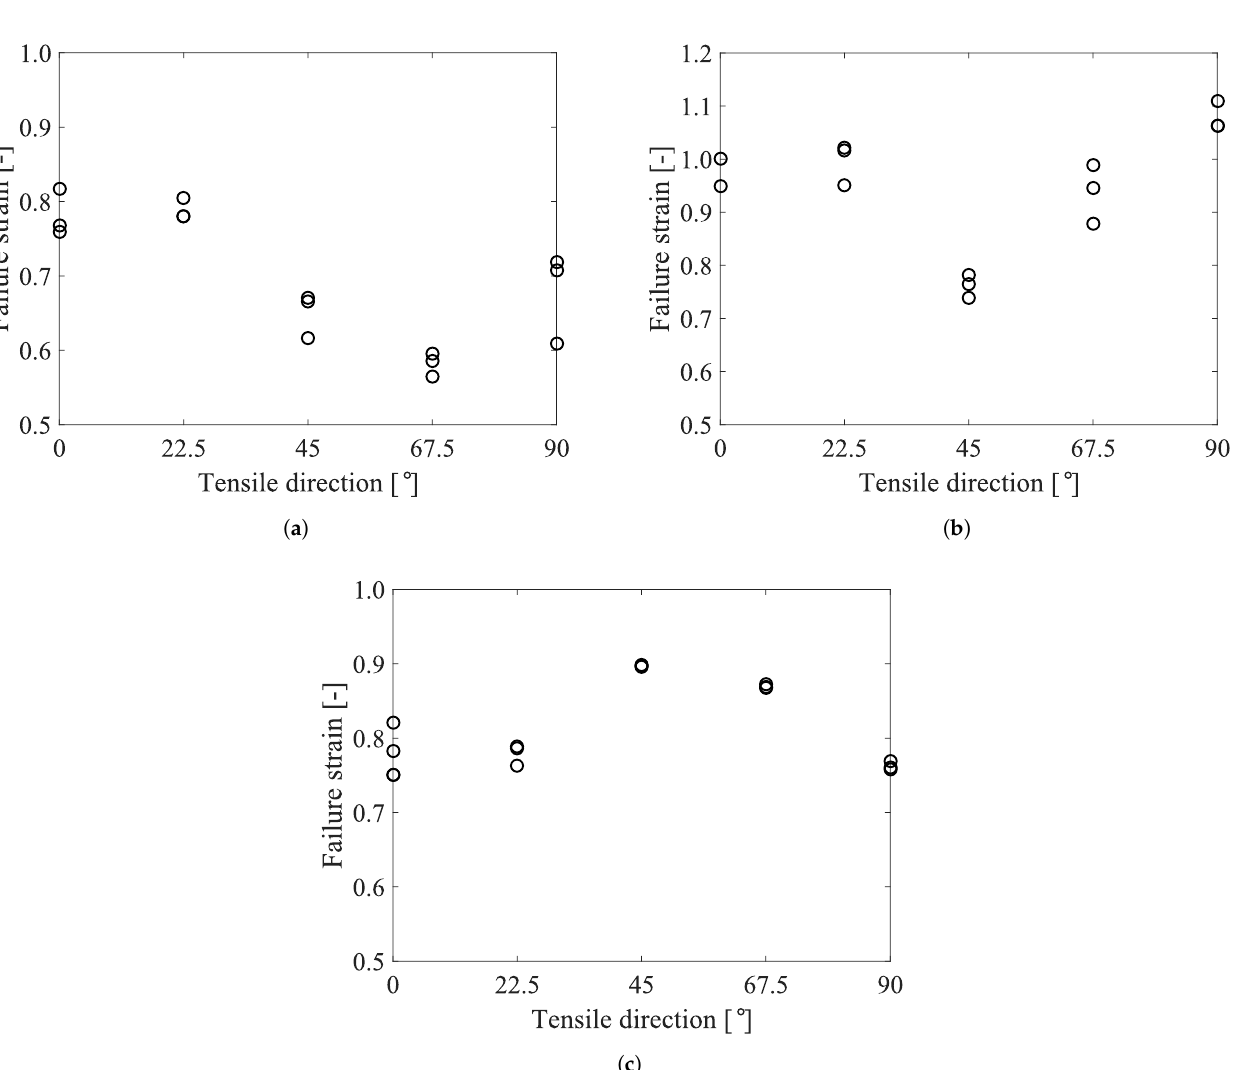
Figure 11. Failure strain versus tensile direction from the tensile tests on the smooth specimen of the alloys ( a ) AA6061, ( b ) AA6063 and ( c )